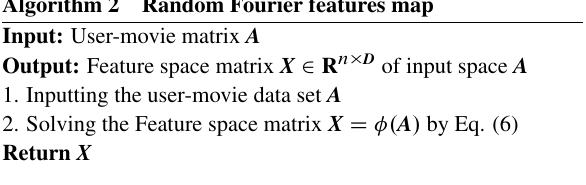
Algorithm 2 Random Fourier features map